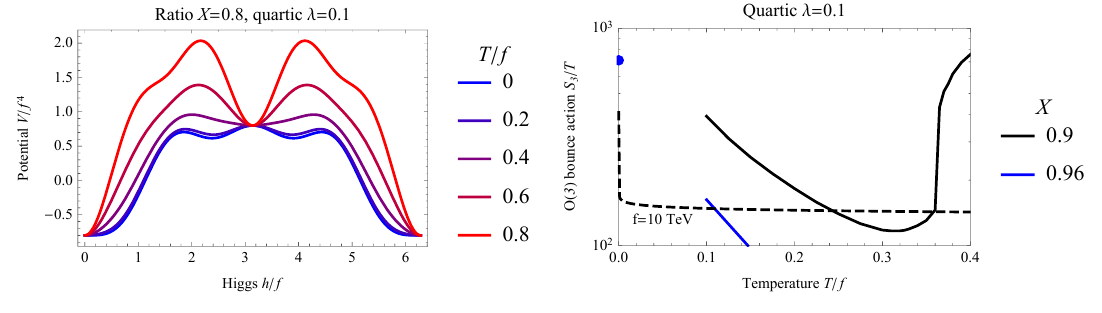
Figure 6 . Same as in (cid:12)gure 5, for the model of eq.